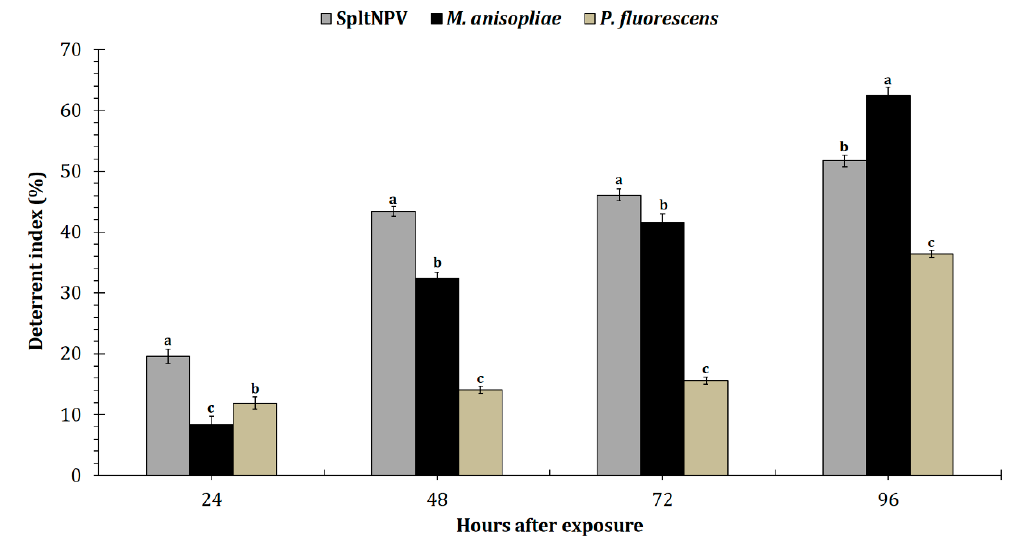
Figure 1. Effect of Spodoptera litura nucleopolyhedrovirus (SpltNPV)-, Metarhizium anisopliae -, and Pseudomonas fluorescens -infected S. litura larvae on the feeding deterrence of the reduviid as measured by the deterrent index (%) during a non-choice test 24, 48, 72, and 96 h post-exposure; all deterrence index values are represented as means ± SEM. Letters above the mean bars per treatment/exposure time that are different are significantly different (Tukey’s test; p < 0.05).